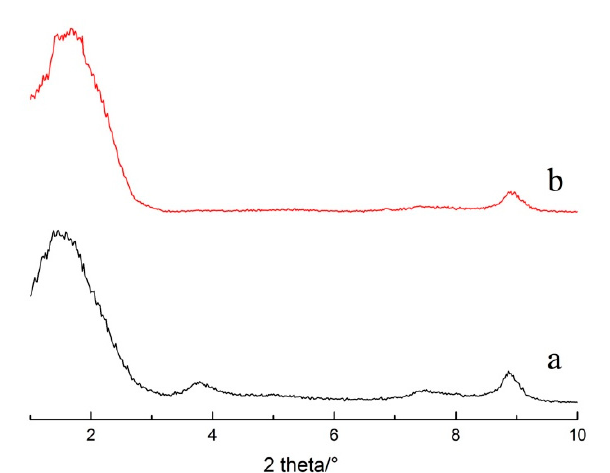
Figure 5. XRD patterns of the intercalated products: a . washed with ultrasonic cleaning; b . washed without ultrasonic without ultrasonic cleaning.